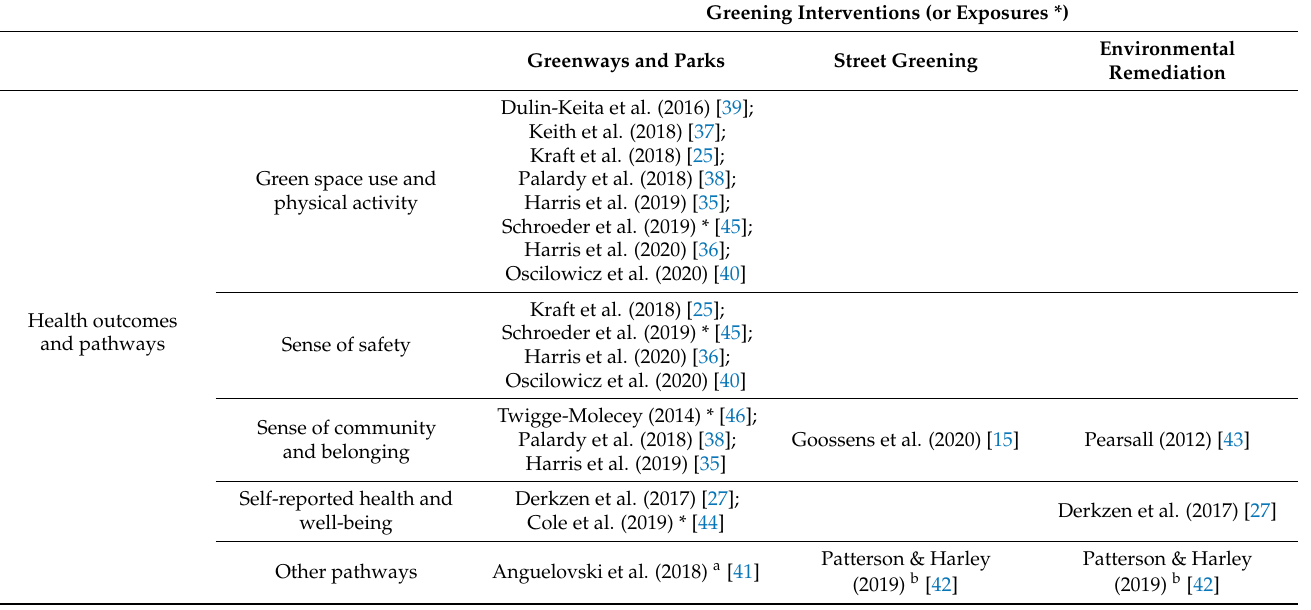
Table 2. The 15 include studies categorized by greening intervention and health outcome/pathway. Greening Interventions (or Exposures